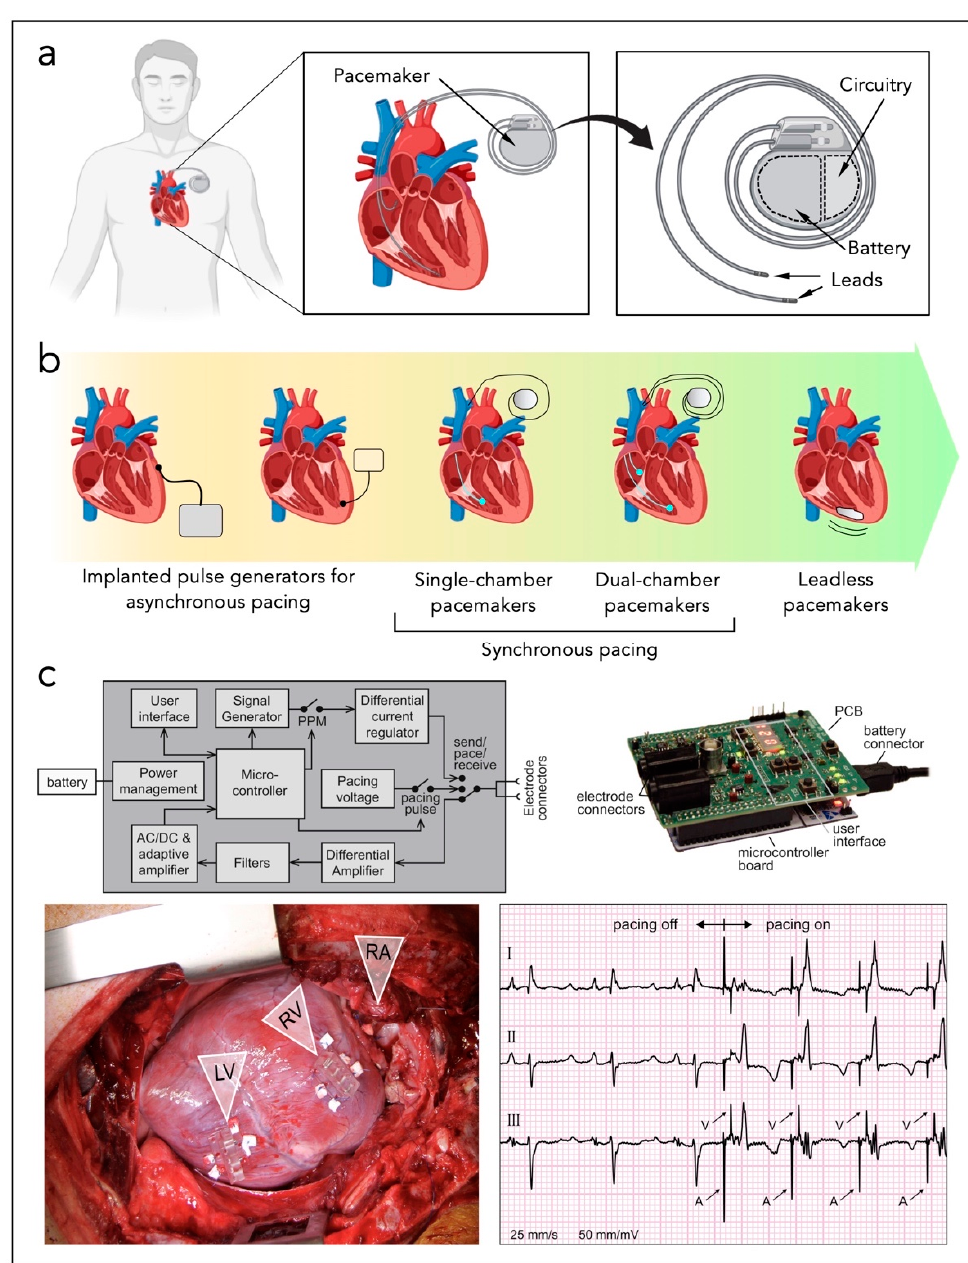
Figure 2. ( a ) Illustration of a standard pacemaker with indication of the space occupied by the battery and the electronic circuitry. ( b ) Evolution of electronic pacemakers: the first implantable devices were big with epicardial leads for asynchronous pacing, modern devices are smaller, endowed with catheter-like endocardial leads which can be implanted with minimally invasive techniques and capable of providing synchronous pacing. More recently, leadless pacemakers have been introduced which can wirelessly provide pacing and can be implanted percutaneously through the femoral vein. ( c ) Example of leadless pacemaker, with the indication of the electronic interface used to provide pacing. Adapted with permission from reference [72], 2018 Copyright Elsevier.